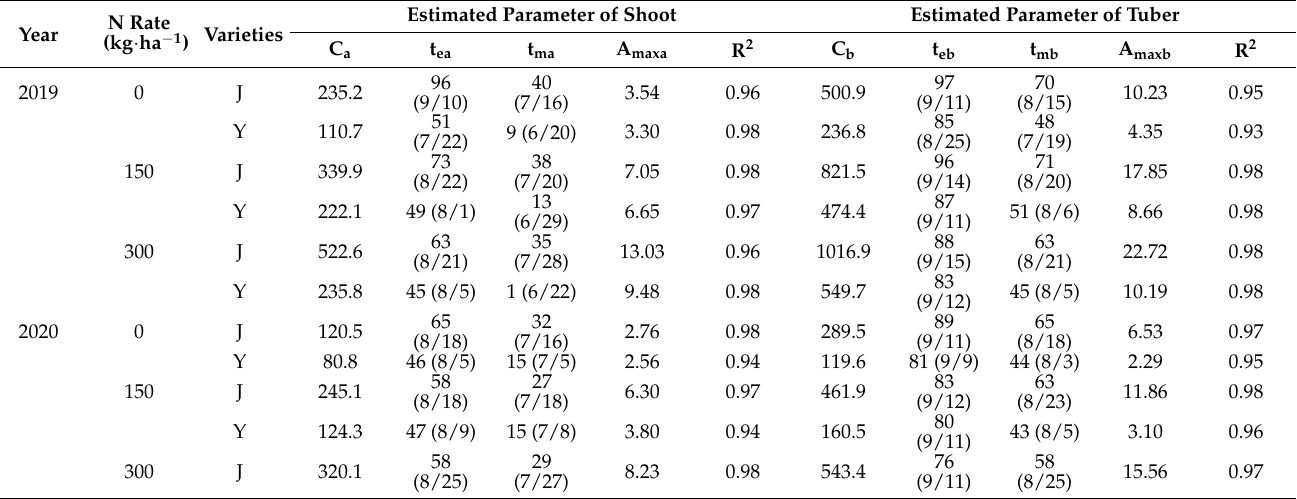
Table 5. Fitting parameter values for shoot and tuber fresh weight of two potato varieties at different nitrogen application